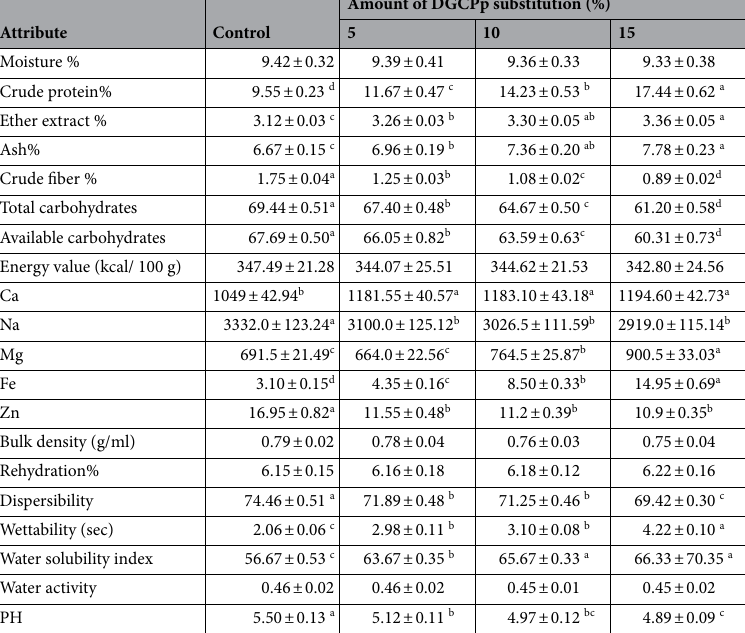
Table 6. Physico-chemical properties of instant DGCPp soup powder. Data are expressed as mean ± SEM. Mean values with different superscript letters [a (the highest values)—d (the lowest value)] in the same row are significantly different at ( p ≤ 0.05). All groups were compared to each